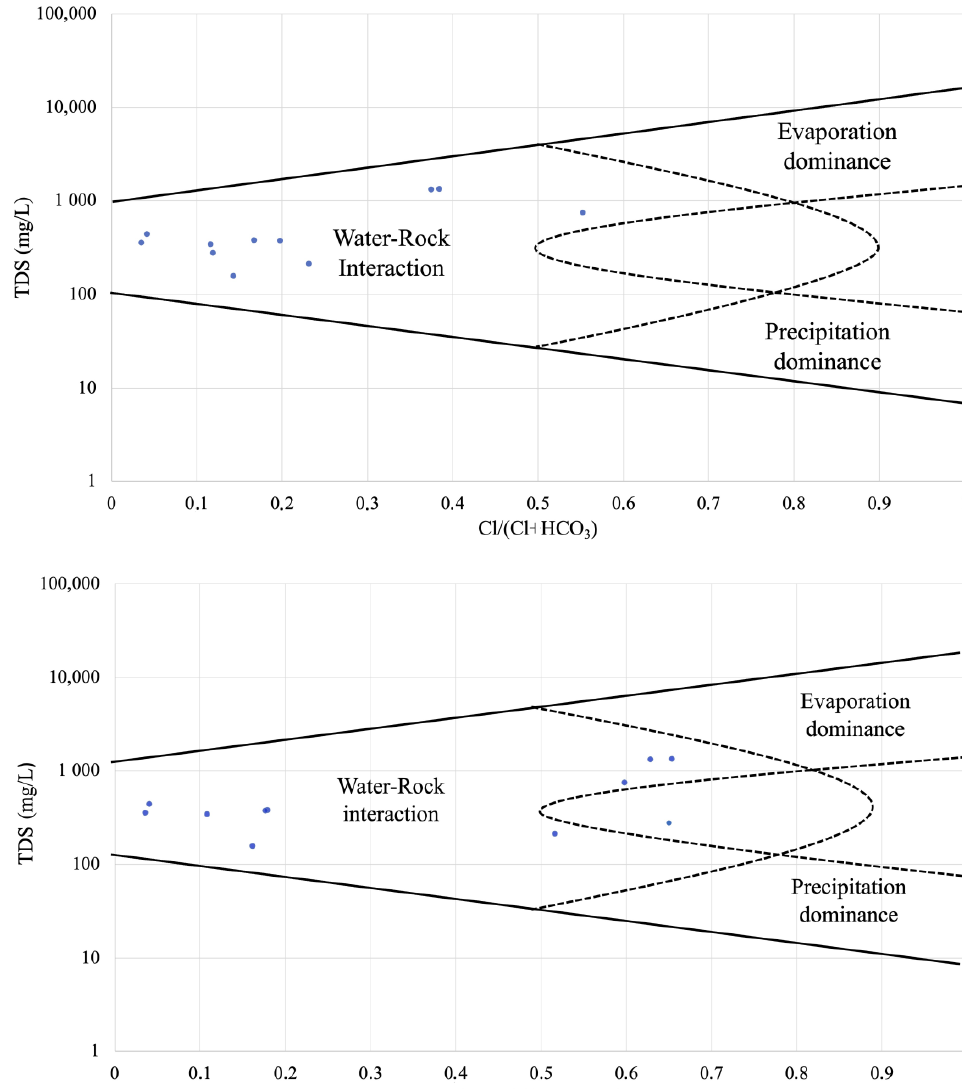
Figure 8. Gibbs diagram.